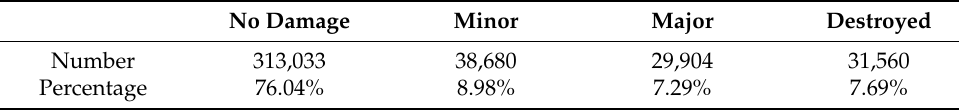
Table 2. The distribution of damage level annotations.